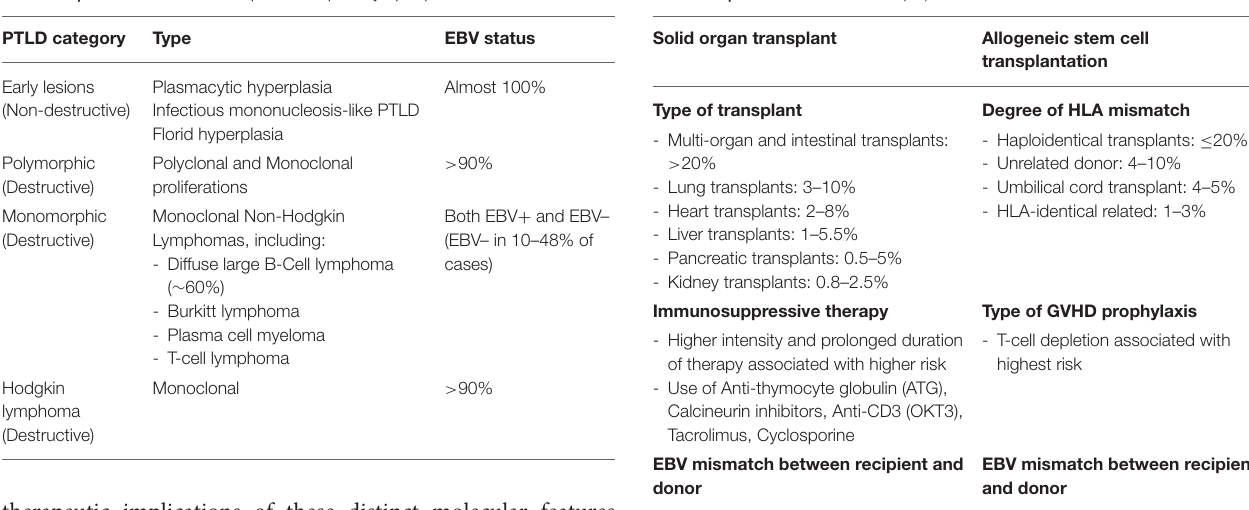
TABLE 4 | Risk factors for PTLD